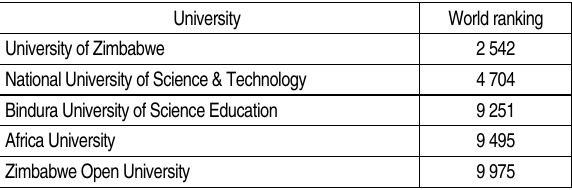
Table 2. Zimbabwean Universities 2015 world